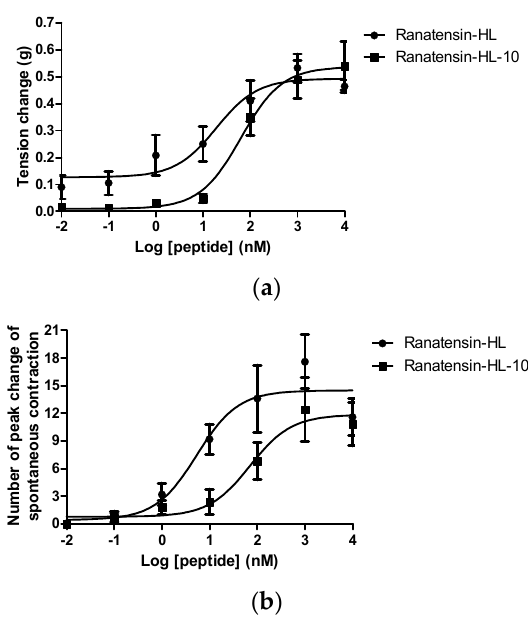
Figure 6. Comparison of myotropic effects of synthetic ranatensin-HL and ranatensin-HL-10 on isolated rat urinary bladder and uterus smooth muscles. ( a ) Dose-response curves of ranatensin-HL and ranatensin-HL-10 using rat urinary bladder smooth muscle preparations. EC 50 values were determined as 19.2 and 63.8 nM, respectively; ( b ) Dose-response curves of ranatensin-HL and ranatensin-HL-10 using rat uterus smooth muscle preparations. EC 50 values were determined as 5.4 and 70.9 nM, respectively. Each data point represents the mean and standard error of five determinations.